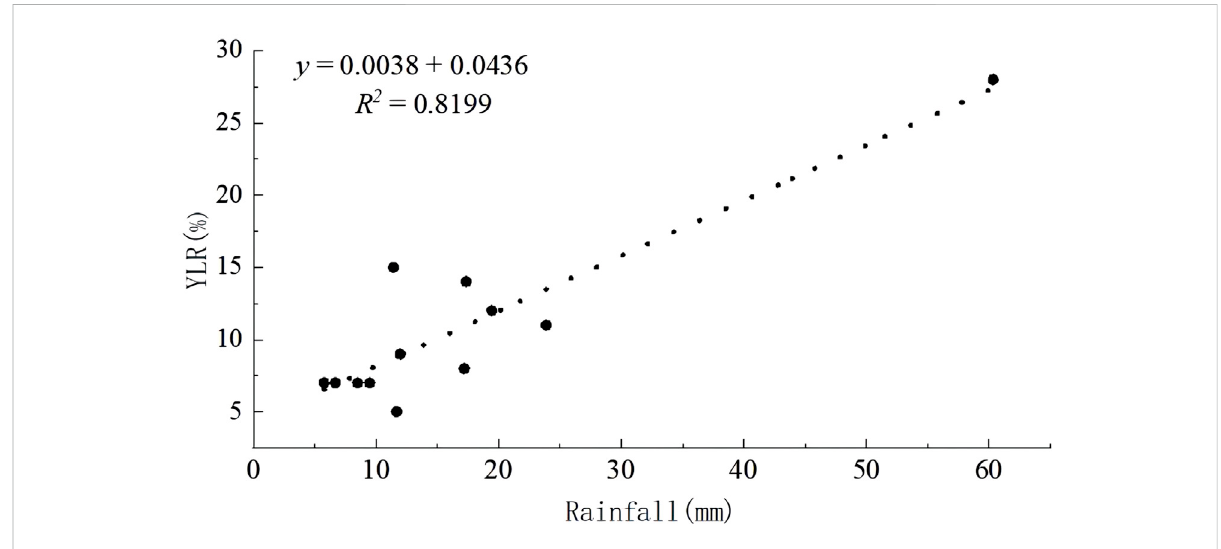
FIGURE 7 Regression graph of yield reduction rate and Precipitation.